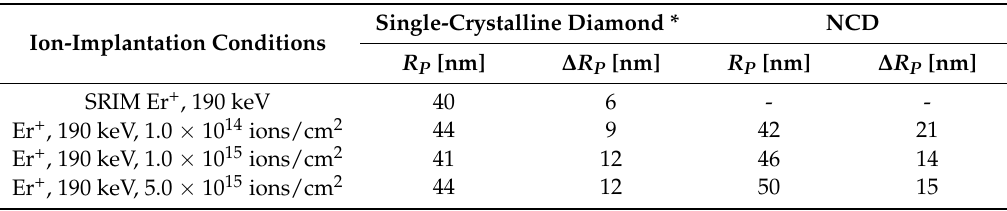
Figure 3. Erbium concentration depth profiles for various implantation fluences determined by the RBS method in ( a ) single-crystalline diamond and ( b ) nano-crystalline diamond thin films. Table 2. The Er concentration depth profile parameters.